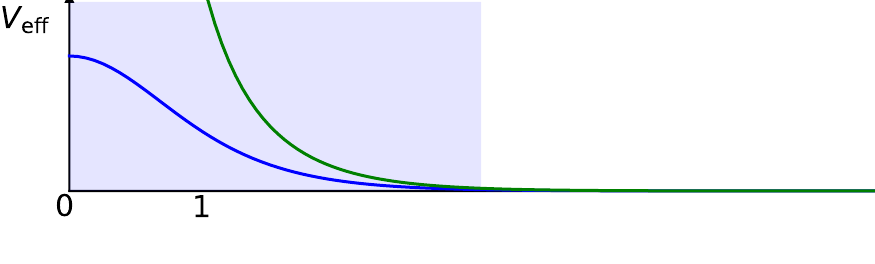
Figure 2 . The effective potential for the spherical harmonics of a free field consists of a mass term (blue) and a centrifugal barrier (green). They decay exponentially toward the horizon x → ∞ . When ω (cid:28) 1 , the interaction region (shaded) can be collapsed to a boundary with localized